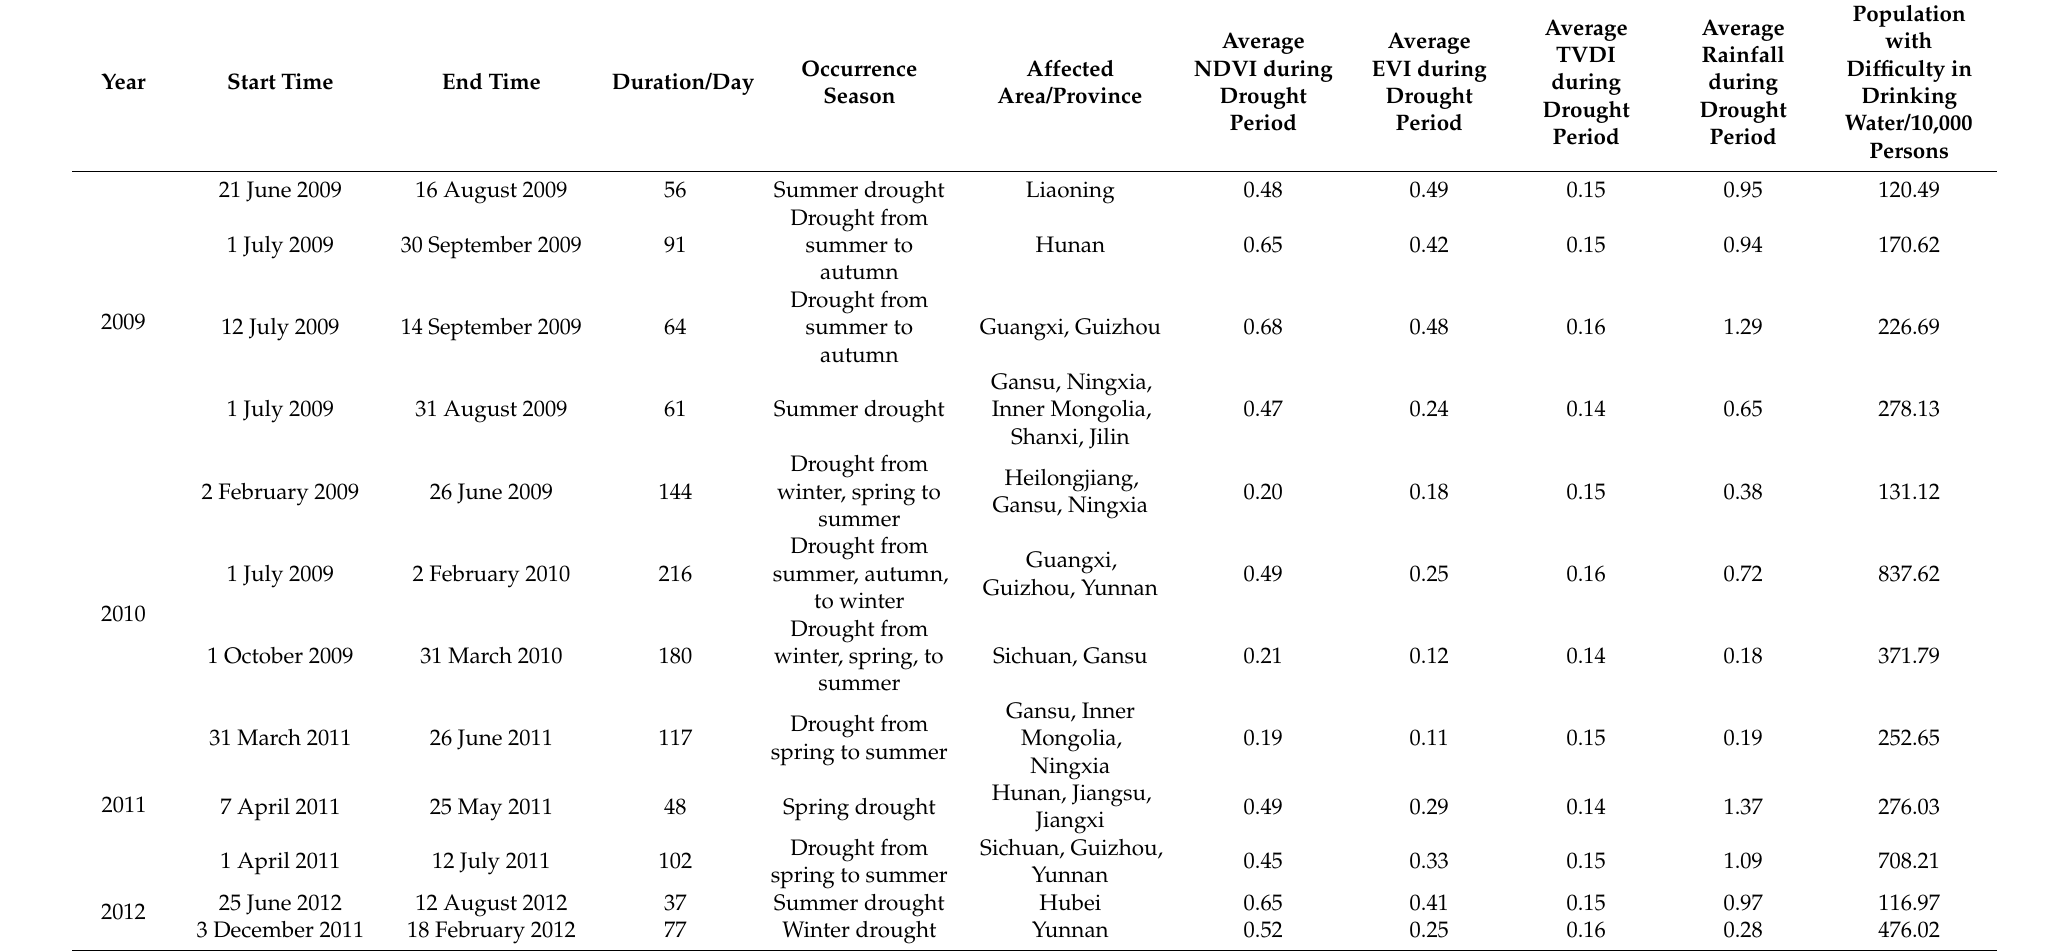
Table 2. Statistics of historical drought event data and remote sensing monitoring